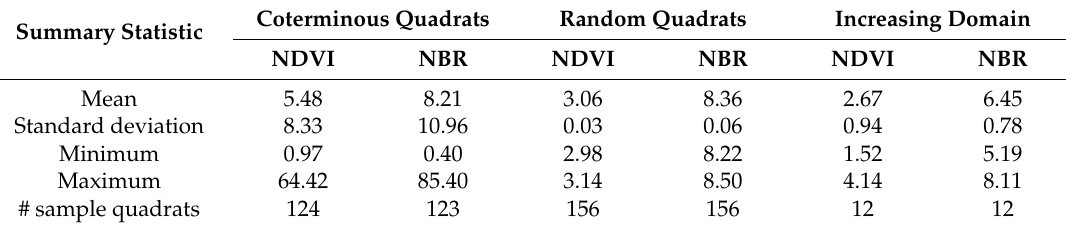
Table 3. Effective sample size percentage, 100 n*/n, for the Florida Everglades remotely-sensed image.